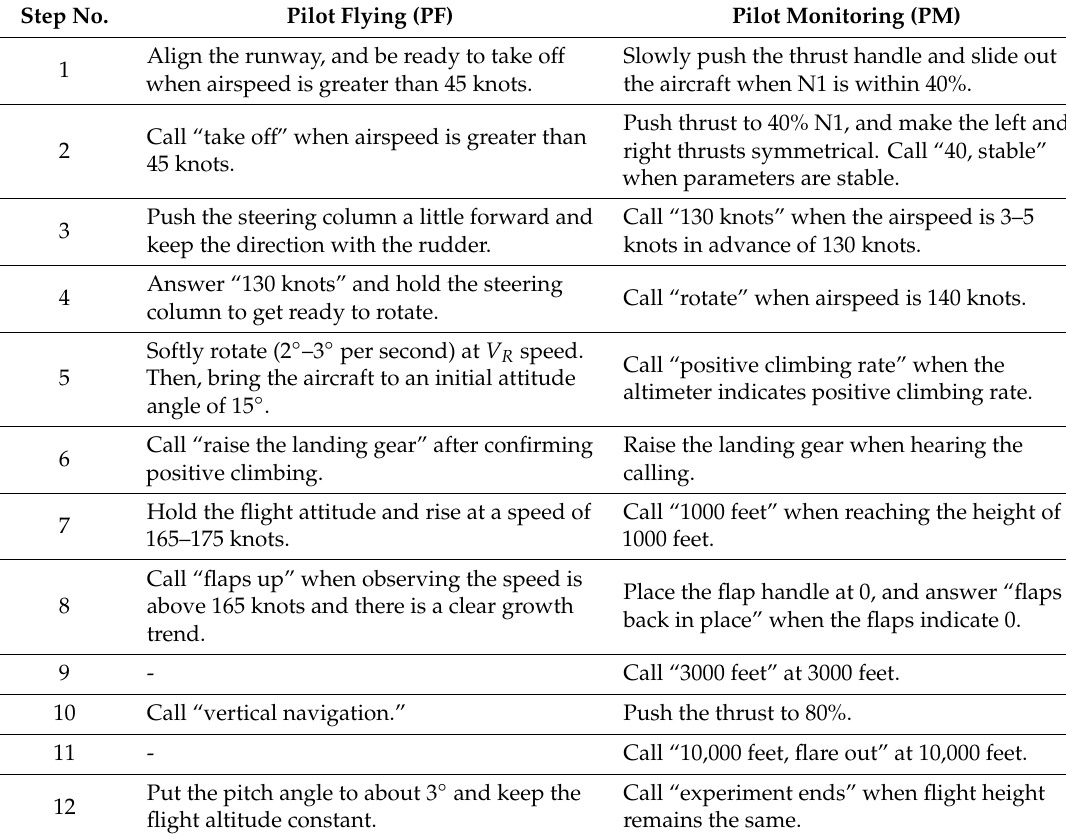
Table 2. Analog takeo ff and initial climbing operation